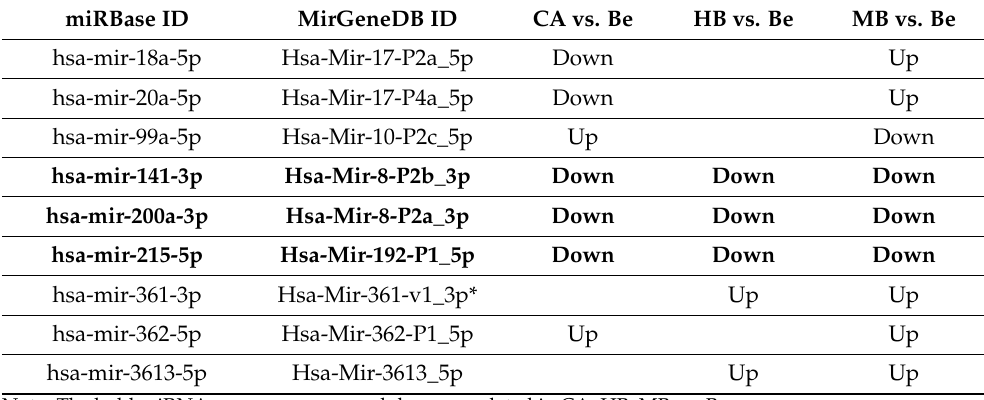
Table 1. Differentially expressed miRNAs in multiple comparisons of CA, HB, MB vs. Be.